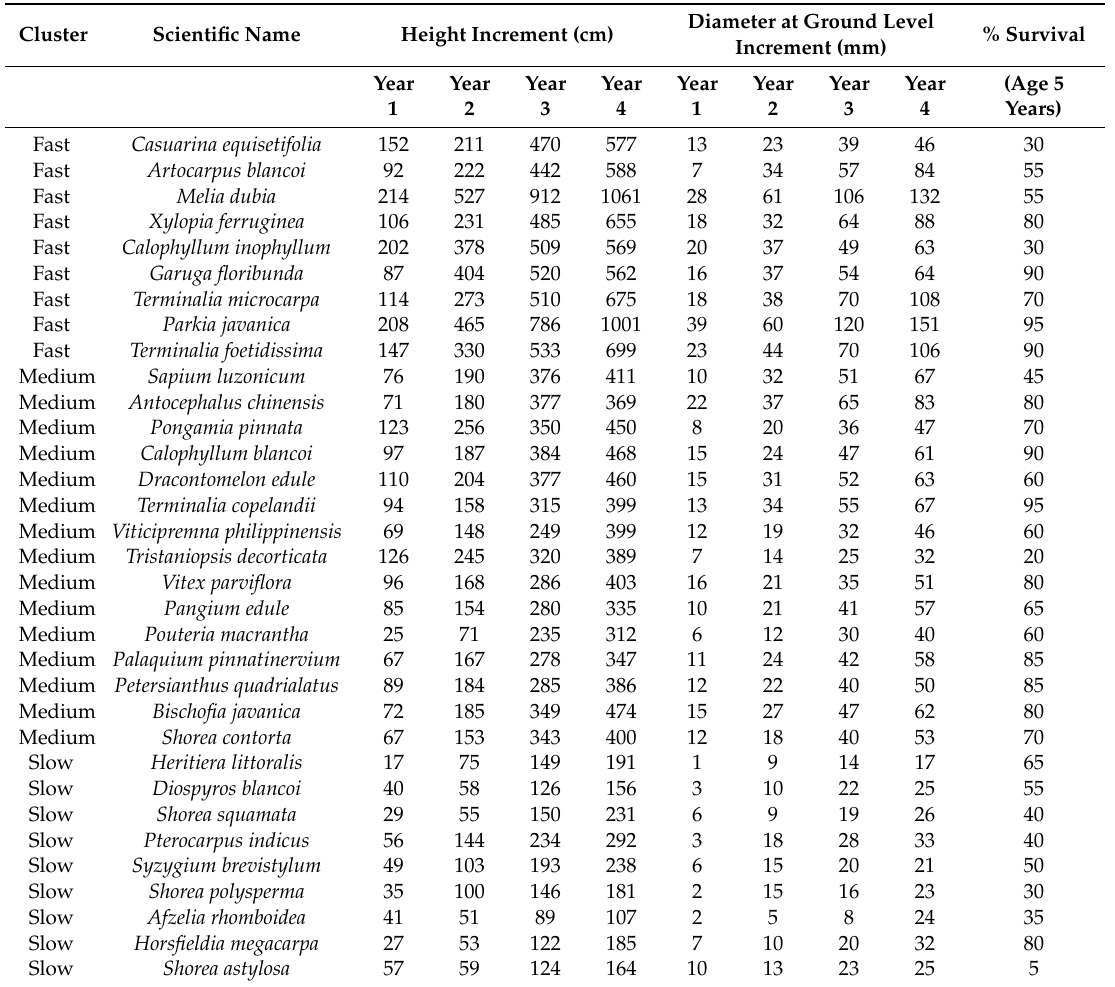
Table 2. Clustered species and their annual average total height and diameter at ground level increments from 2014 to 2018 (Years 1 to 4). Survival rate was determined at the end of the measurement period in